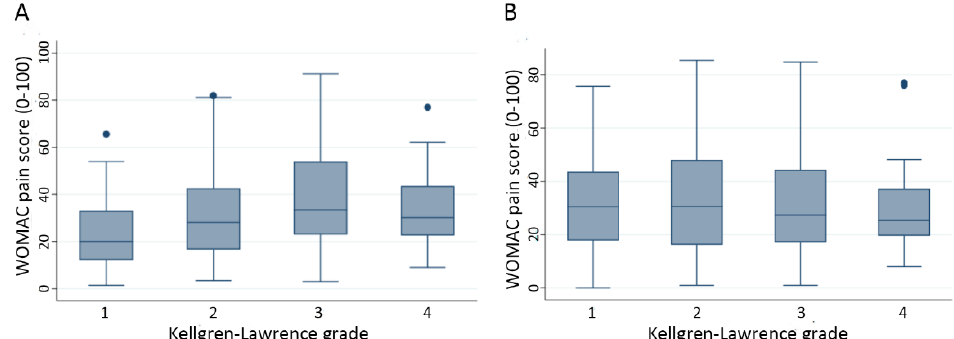
Figure A3. WOMAC pain score by Kellgren–Lawrence grade. ( A ) MRI imaging dataset; ( B ) biochemical markers